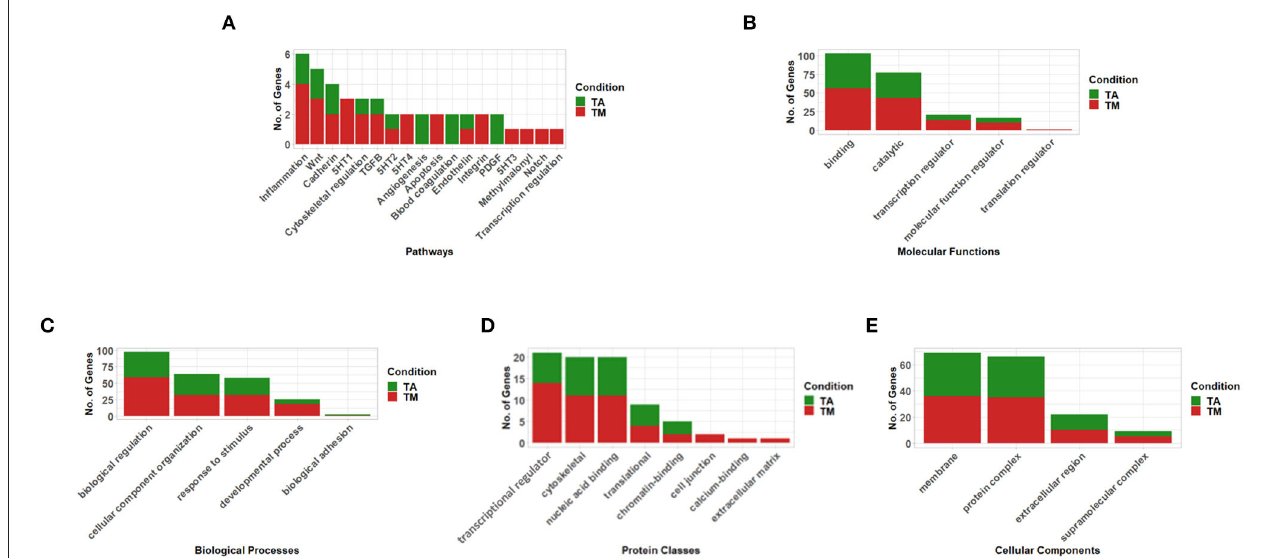
FIGURE 3 | Functional classification of genes associated with differentially methylated promoters (q-value < 0.05 & meth.diff > |10|) between aortic and mitral tissue according to (A) Pathways, (B) Molecular Functions, (C) Biological Processes, (D) Protein Classes and (E) Cellular Components (selected results, the remaining can be found in Supplementary Figure 5 – analysis performed using PANTHER). In the stacked bar graphs, TA (green) labels genes with promoters that show increased methylation in the aortic compared to the mitral valves and TM (red) shows genes whose promoters exhibit increased methylation in the mitral compared to the aortic